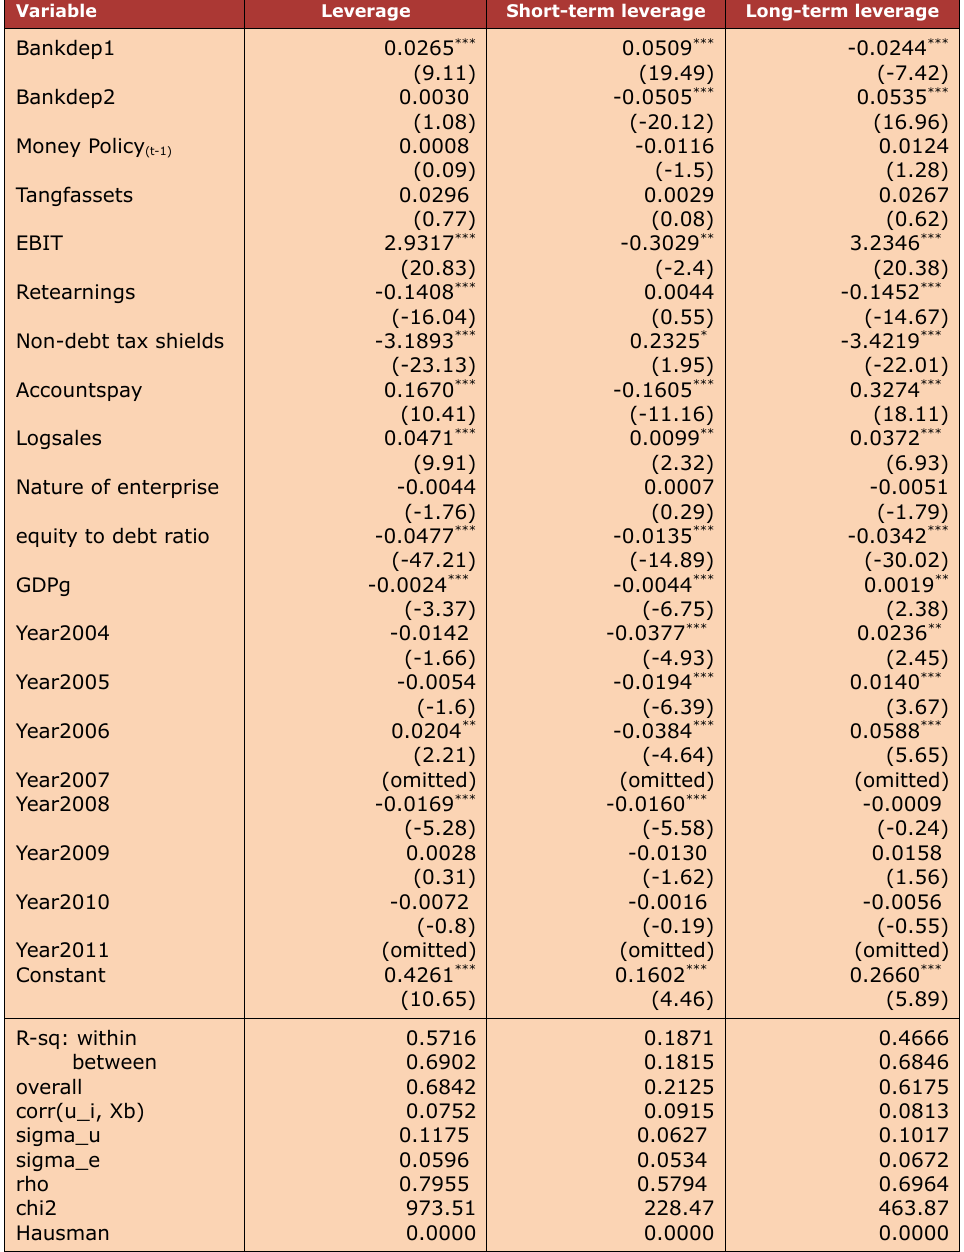
Table 8. Fixed-effects Regression of